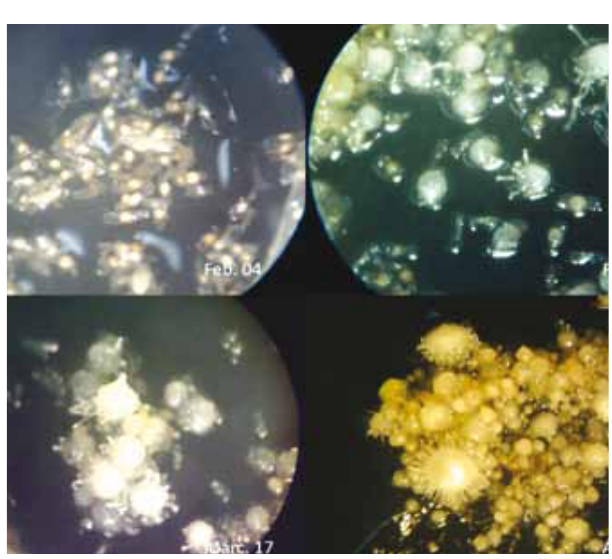
Figure 20: Asymbiotic seed sowing and in vitro planting of rare european orchid